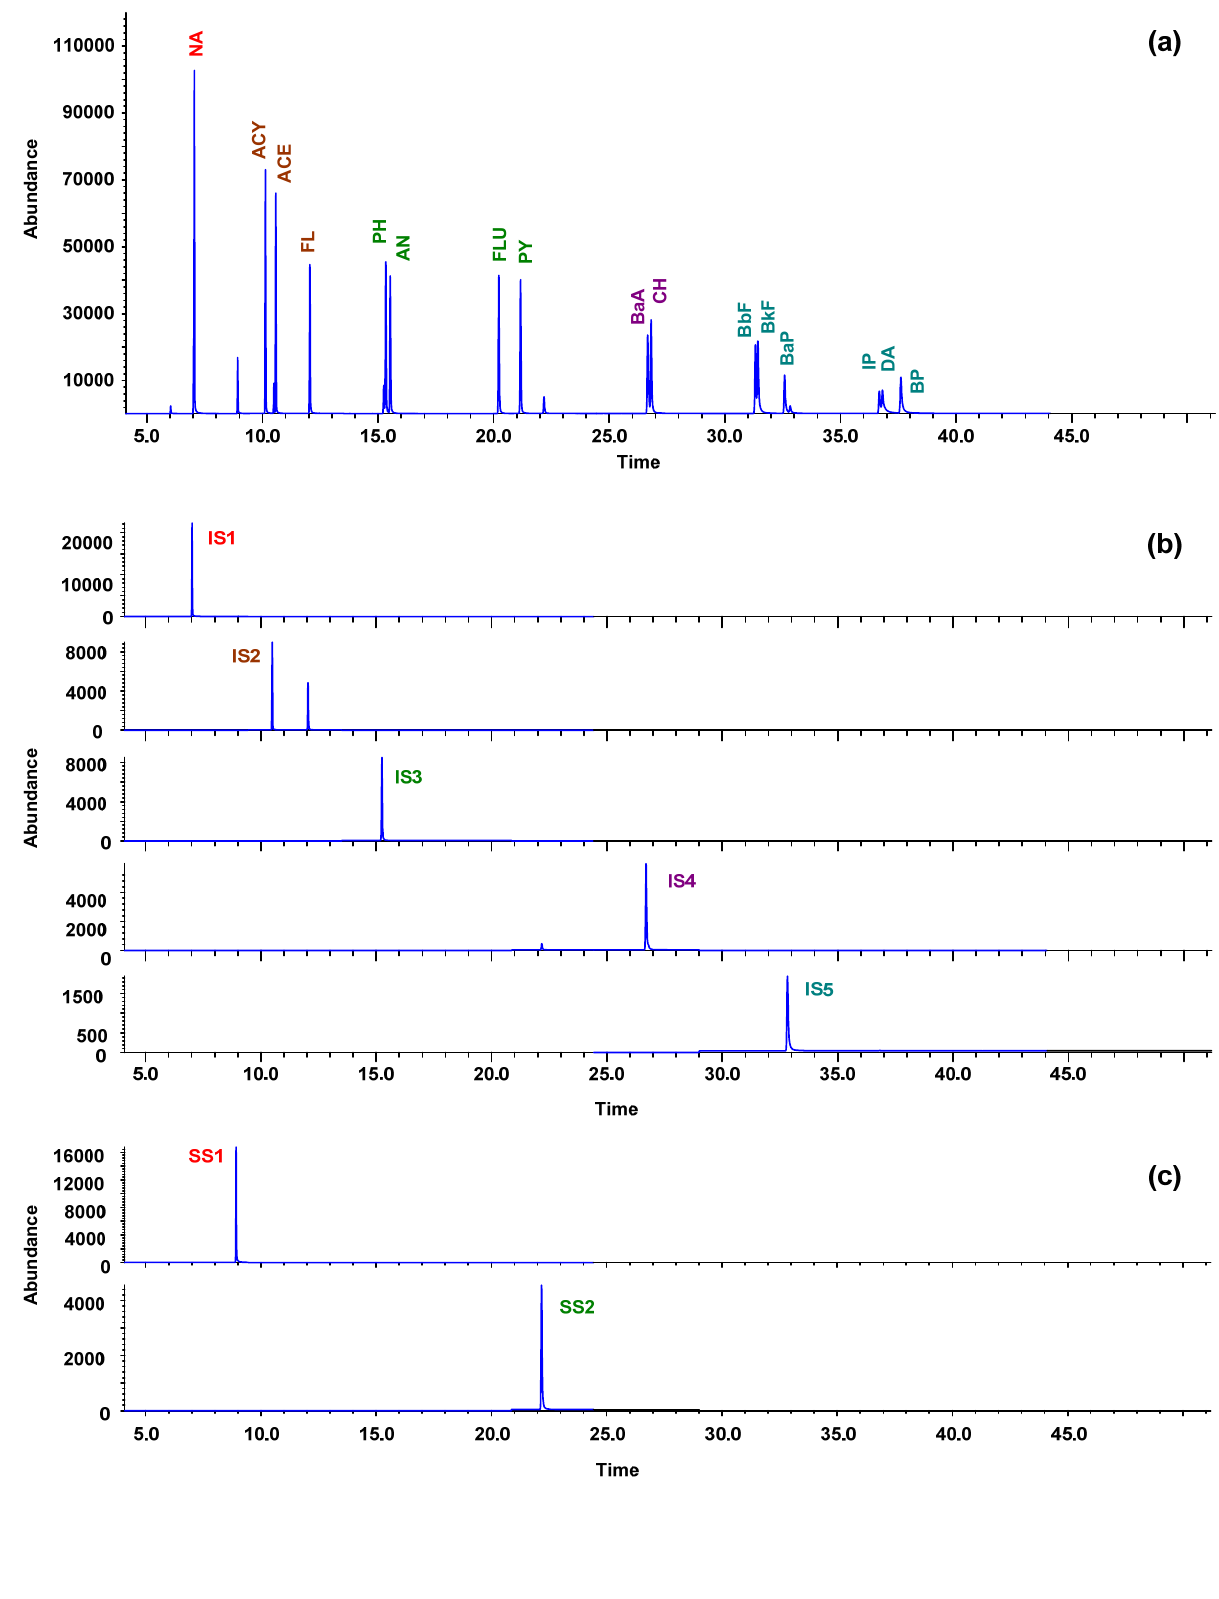
Figure 2. ( a ) GC-MS total ion chromatogram of sixteen PAHs, ( b ) selected ion chromatograms of the five internal standards, namely naphthalene-d (IS1), acenaphthene- 8 d (IS2), phenanthrene-d (IS3), chrysene-d (IS4), and perylene-d (IS5), ( c ) two 10 10 12 12 surrogate standards, 2-fluorobiphenyl (SS1) and 4-terphenyl-d 14